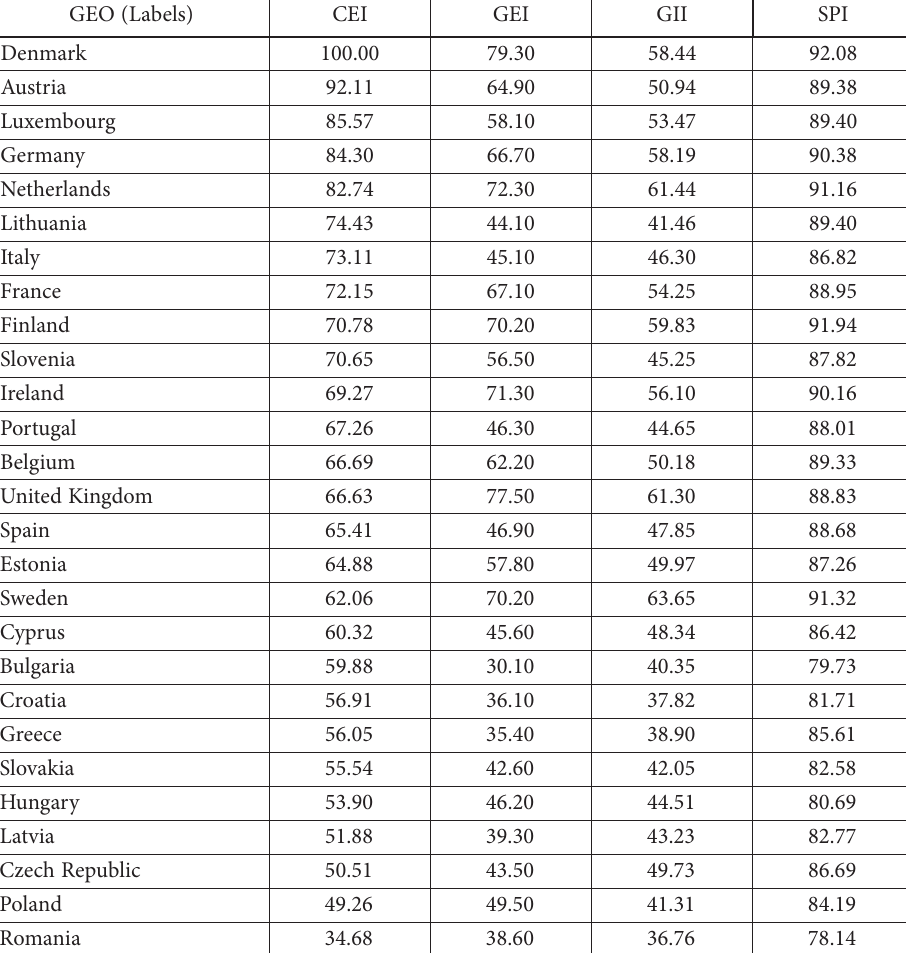
Table 2. The values of the indicators for the countries included in the analysis GEO